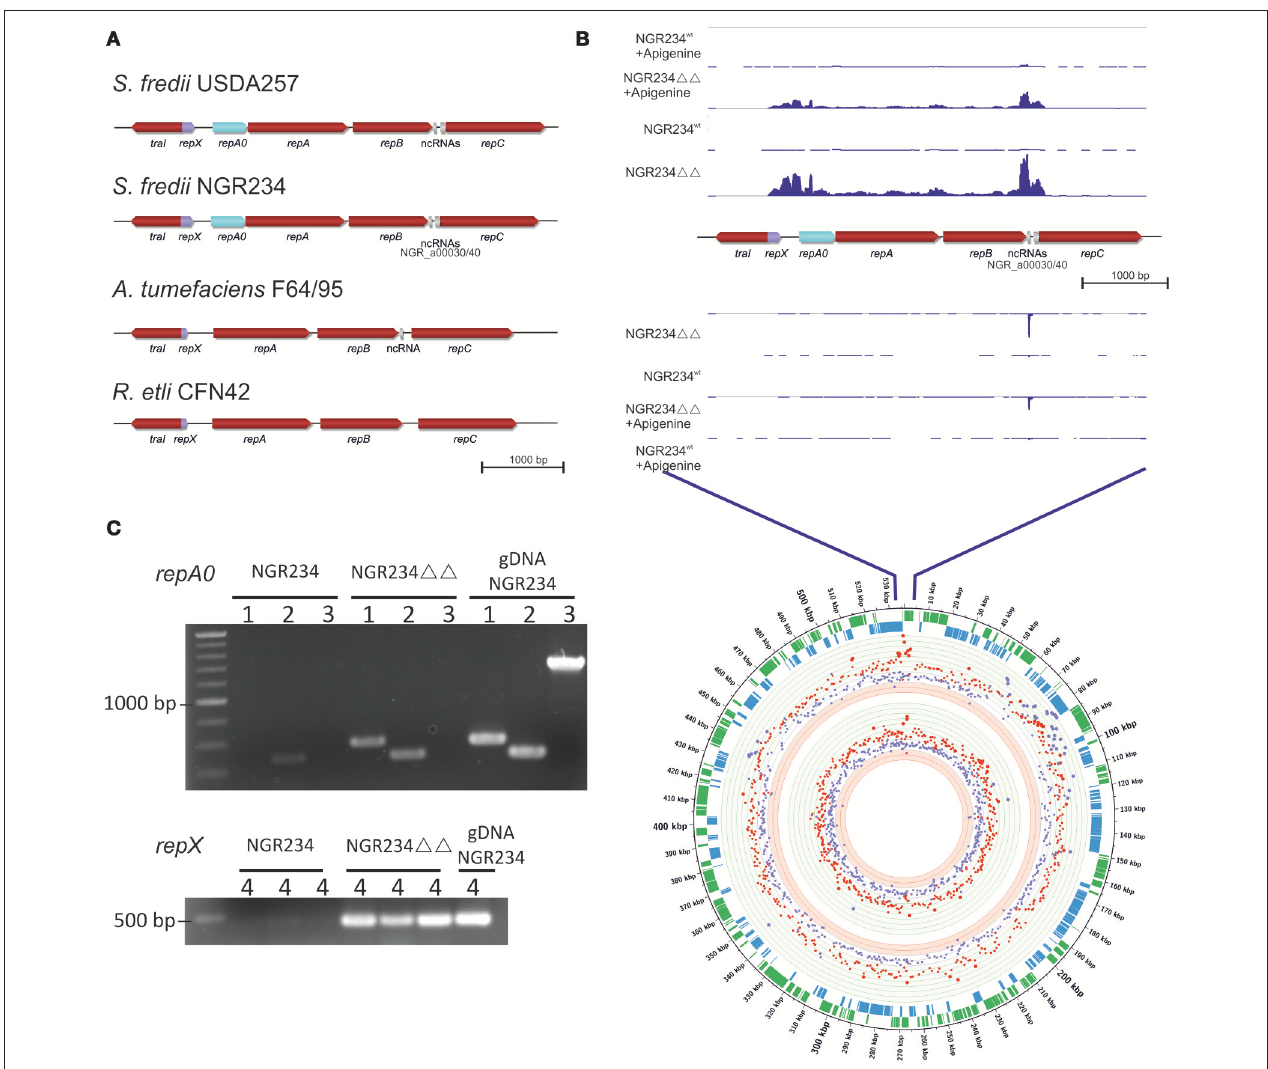
FIGURE 1 | Genomic organization and analyses of repX and repA0 . (A) Genomic organization of the traI and repABC genes including the noncoding RNAs (NGR_a00030/40) and the two ORFs repX and repA0 in the intergenic region between traI and repA of the two broad host range strains Sinohrizobium fredii NGR234 and USDA257 and two closely related strains Agrobacterium tumefaciens F64/95 and Rhizobium etli CNF42. Sequences were extracted from NCBI accession numbers NC_000914.2, NC_018000.1, NC_019555.1 and NC_007762.1 and compared to the GenBank entry BK009410. (B) The upper part of this picture represents the mapped transcripts on the genomic section around the origin of replication in induced (1 µ M apigenin) and in uninduced NGR234- △ traI - △ ngrI and wild type cells. The image was composed using the integrated genome browser software version 8.4.4. Mapped transcripts above the annotated genes represent transcripts on the leading strand and mapped transcripts under the annotated genes represent transcripts on the lagging strand. The lower part of this figure section shows a circular representation of the RNA-seq-based transcriptome data for pNGR234 a of the NGR234- △ traI - △ ngrI mutant vs. the wild type and the wild type strain induced with apigenin vs. the uninduced wild type. The circular diagram was calculated using the circos software 0.64 (Krzywinski et al., 2009). Fold change cut-off: log 2 8/ − 3 (circle size by values). The circle described from the outside to the innermost circle: Outer circle indicates coordinates of the pNGR234 a in kbp. The second and third circles indicate the ORFs on the leading (green) and the lagging (blue) strand. The circles in light green indicate log 2 8; 7; 6; 5; 4; 3; 2, the white circles in-between the colored once represent log 2 1/ − 1 and the light red circles indicate log 2 − 2; − 3 for the sense transcripts. The next circles represent the same log 2 values for the antisense transcripts. The dots scattered over the light green, light red and white circles represent the transcripts of NGR234- △ traI - △ ngrI in comparison to the wild type strain (red) and the wild type strain induced with 1 µ M apigenin in comparison to the wild type strain (purple). (C) End point RT-PCR of repA0 and repX on cDNA generated of RNA from the wild type and NGR234- △ traI - △ ngrI . Samples are shown on a 0.8% agarose gel with a 1 kb λ marker (Thermo Scientific, Braunschweig, Germany). Primer pairs used for the amplification: 1, amplification of the repA0 gene (parA_int_fw and parA_int_rev); 2, amplification of the repA gene (RT_repA_fw and RT_repA_ rev); 3, amplification of a possible elongated repA gene (parA_int_fw and RT_repA_ rev); 4, amplification of the repX gene in three independent biological samples (repX_int_fw and